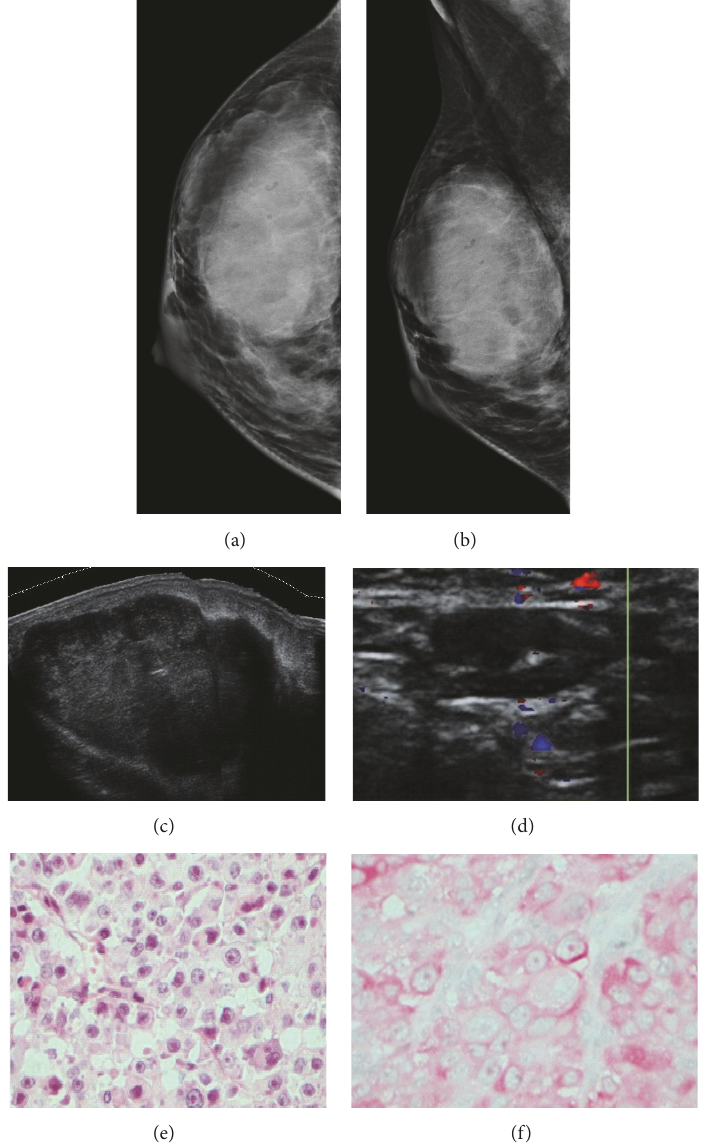
Figure 6: Case 6. A 20-year-old woman with nodular melanoma. The patient presented with a 9-month history of nevus in the neck around the middle line. The woman was lost to follow-up before surgery, and 10 months later, she returned with a palpable mass in the right breast. Mammogram showed an oval mass with circumscribed margins ( a–b ). Ultrasound images demonstrated a sizeable oval mass with a parallel orientation , circumscribed margins, and absent posterior acoustic findings ( c ). A lymph node with irregular cortical enhancement was also exhibited ( d ).HE staining and immunohistochemistryanalysis of themetastases. HE staining revealed the malignant cellsin thebreast